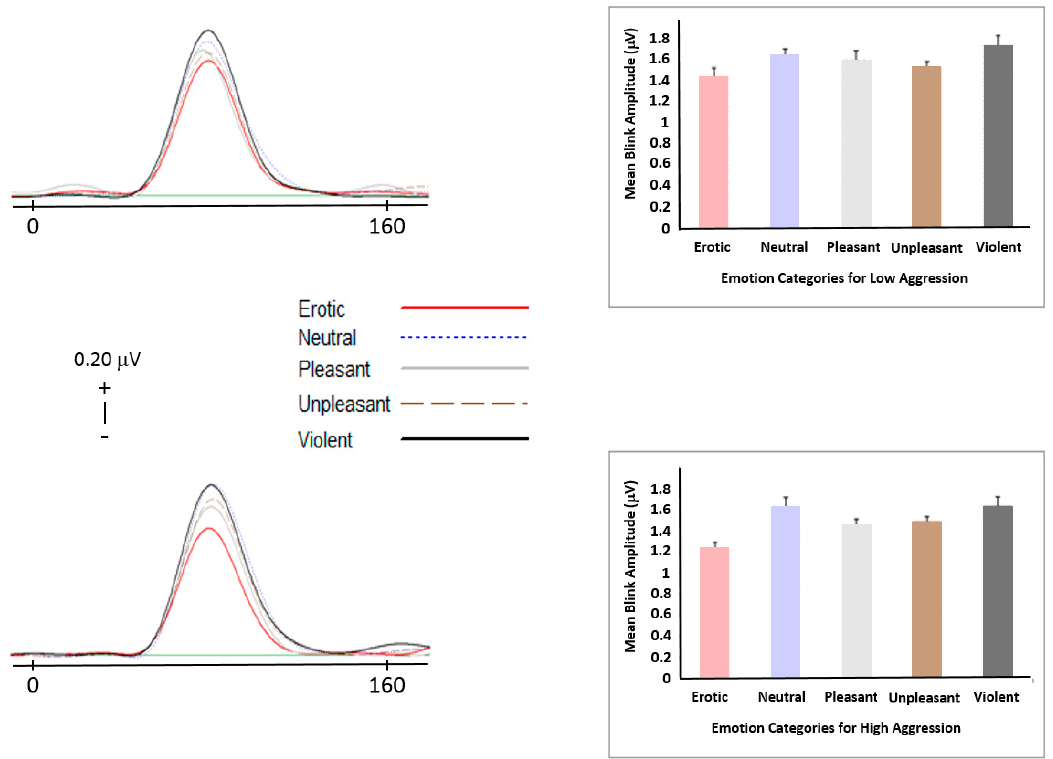
Figure 2. Startle reflex curves and column graphs for low (top graph) and high (bottom graph) aggression groups.